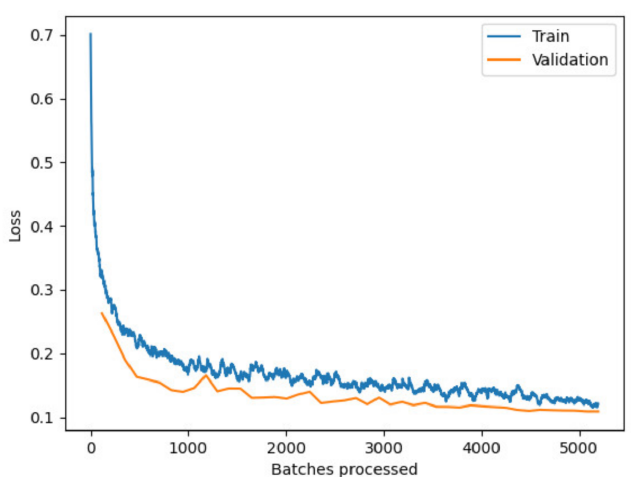
Figure 5. Res-UNet loss curve, where the x -axis indicates the number of training